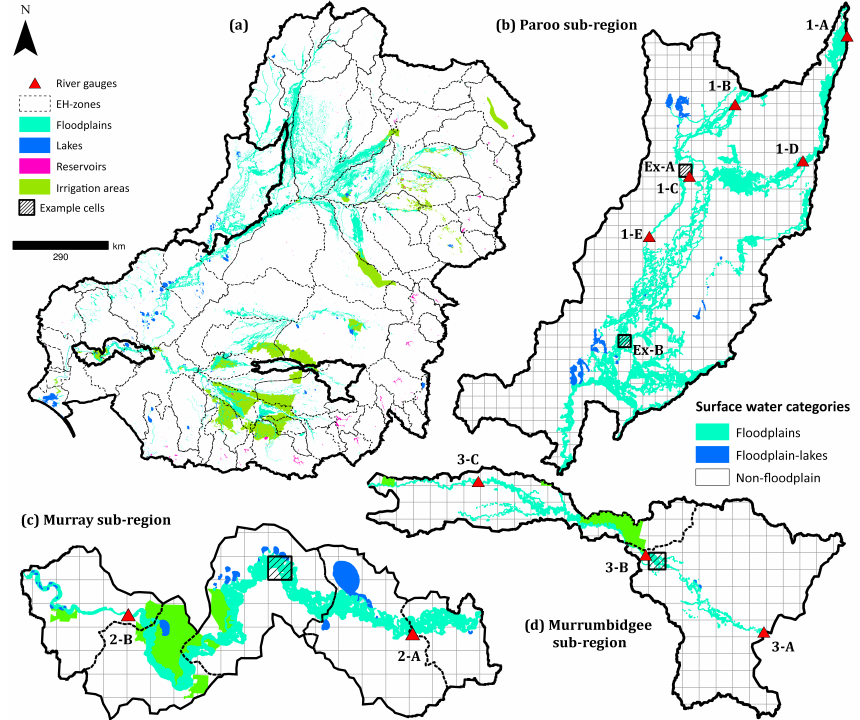
Figure 3. (a) Eco-hydrological zonation, irrigation areas, and wetlands of the Murray–Darling Basin and surface water categories of the three sub-regions – (b) Paroo, (c) Murray and (d) Murrumbidgee – used for illustrating the abilities of the spatial modeling framework for modeling SWE dynamics on a local scale (per grid cell) across large river basins. Sources: surface water categories derived from Kingsford et al. (2004), eco-hydrological zonation (Huang et al., 2013), and irrigation areas (Bureau of Rural Sciences,